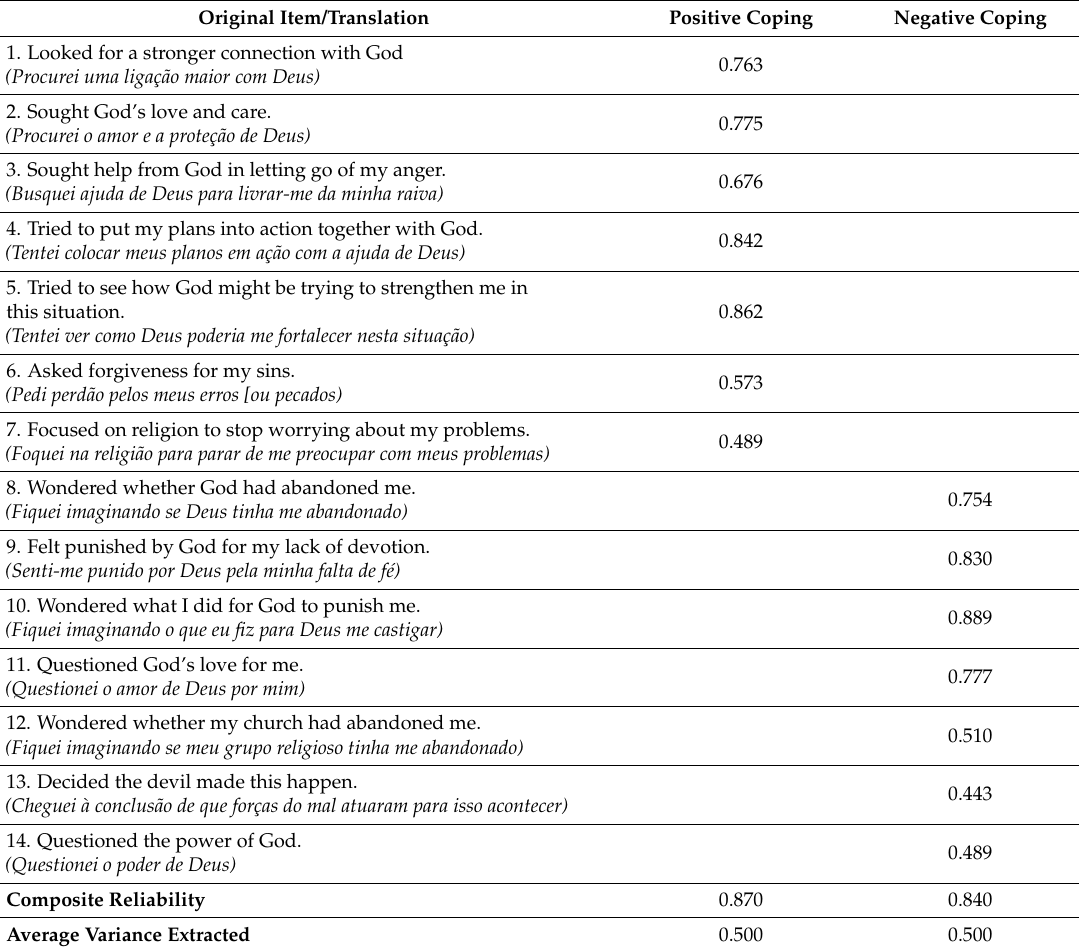
Table 2. Regression Weights, Reliability and Convergent Validity